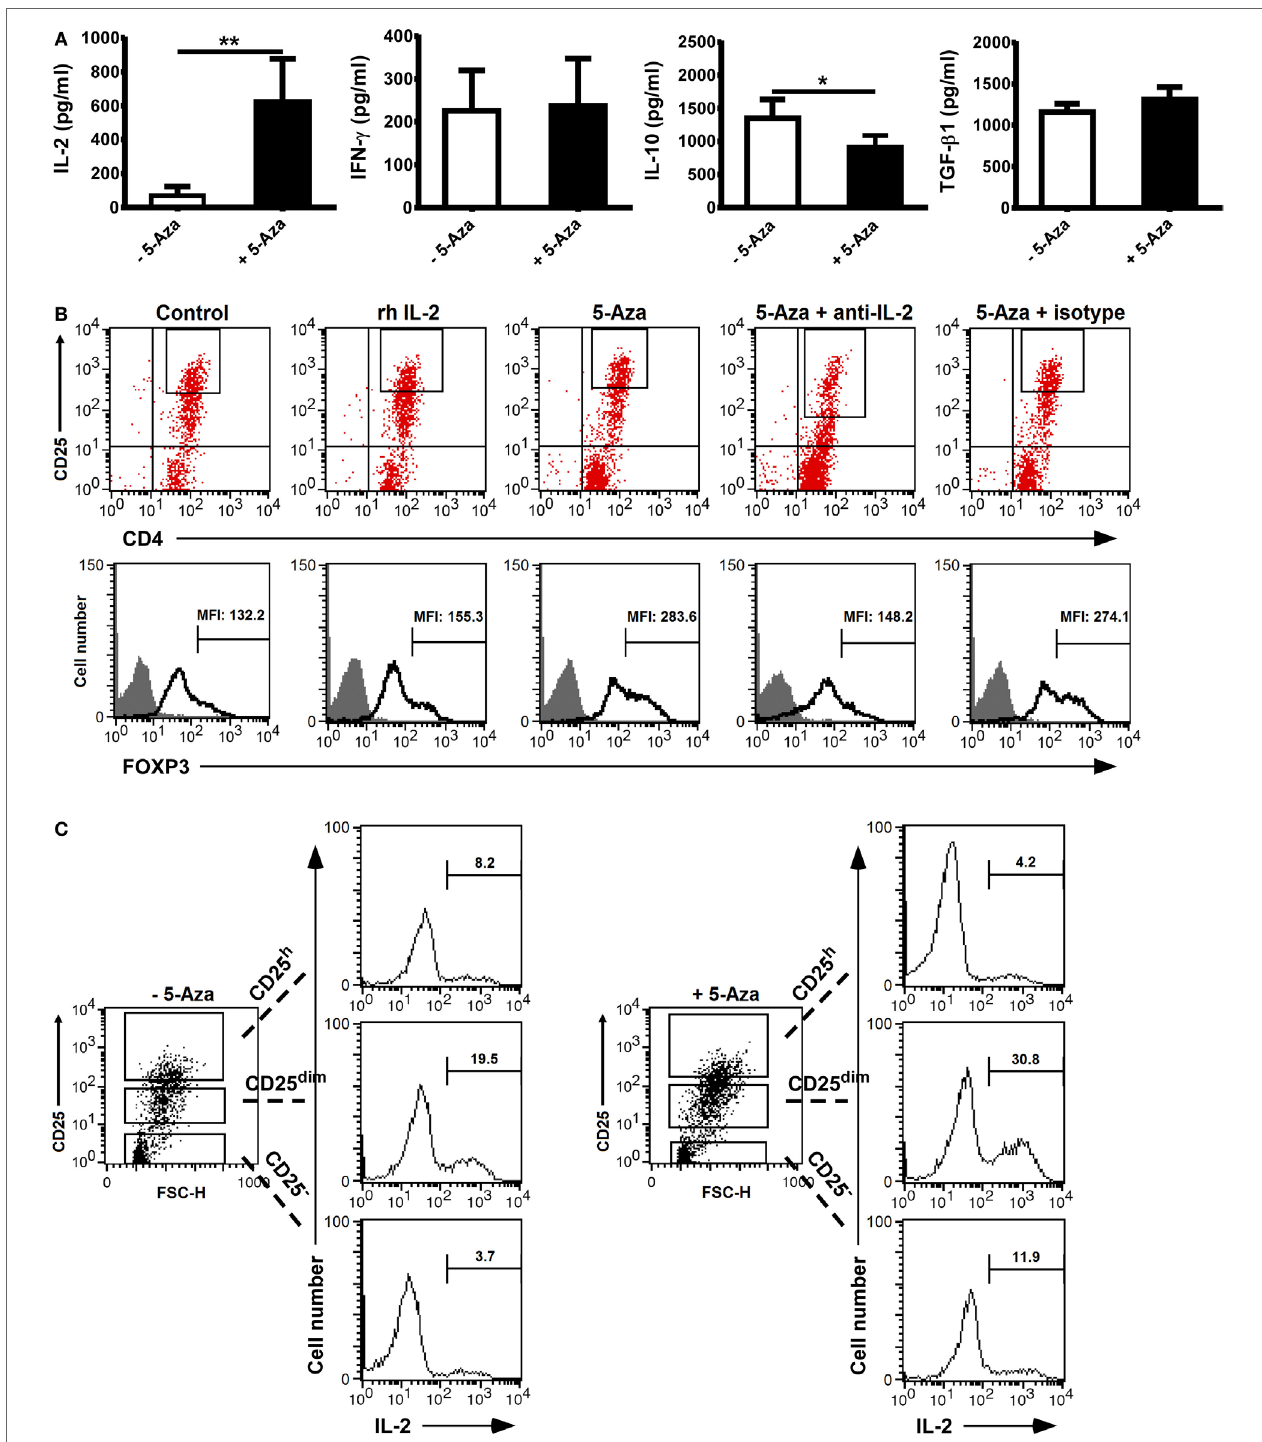
FigUre 4 | neutralization of il-2 which was majorly produced by cD25 dim cells impeded the enhanced FOXP3 expression in cD25 h cells treated with 5-aza . CD4 + CD25 − T cells were activated with anti-CD2/CD3/CD28 antibody-coated beads at a bead-to-cell ratio of 1:8 in the presence or absence of 5-Aza for 4 days. (a) IL-2, IFN- γ , IL-10, and TGF- β in the cultured supernatants were measured by ELISA. Data are representative of nine independent experiments. The results are shown as mean ± SD (* P < 0.05; ** P < 0.01). (B) Neutralizing anti-IL-2 antibodies and recombinant IL-2 were added simultaneously to the cells treated with 5-Aza and without 5-Aza, respectively. FOXP3 was examined in the CD25 h cells by FACSCalibur, and FOXP3 dim cells were excluded. (c) After the incubation with 5-Aza, cells were restimulated with PMA and ionomycin for an hour followed by GolgiPlug treatment for another 3 h. Intracellular IL-2 was analyzed by FACSCalibur. One representative result of six (B) and three (c) experiments is shown.